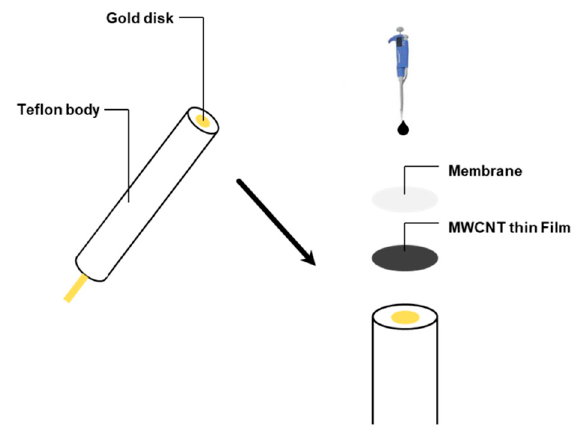
Figure 1. Sensor construction using multiwalled carbon nanotubes (MWCNTs)